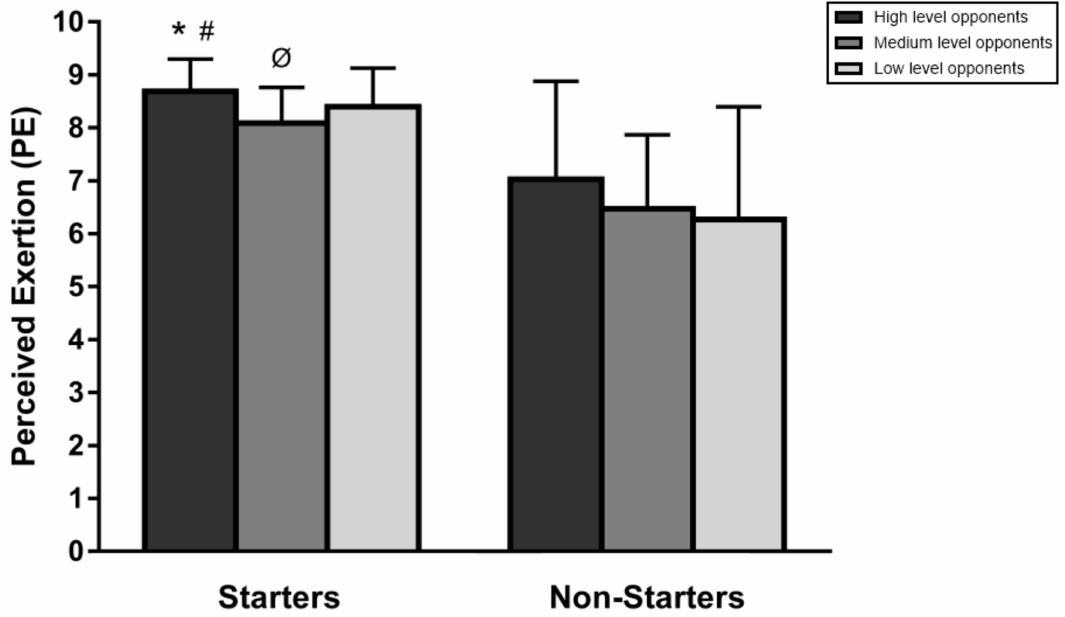
Figure 2. PE for starters and non-starters attending to the level of the opponents. * Significant di ff erences between high- and medium-level opponents ( p < 0.01), # Significant di ff erences between high- and low-level opponents ( p < 0.01), Ø Significant di ff erences between medium- and low-level opponents ( p <